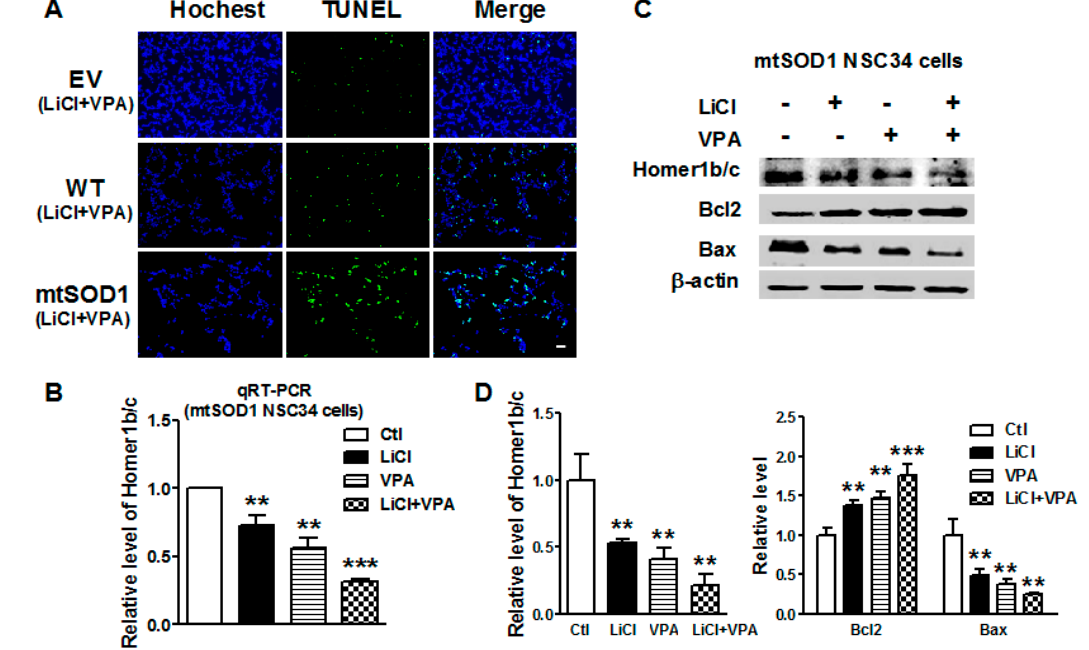
Figure 4. Lithium and valproic acid (VPA) reduced Homer1b/c expression and